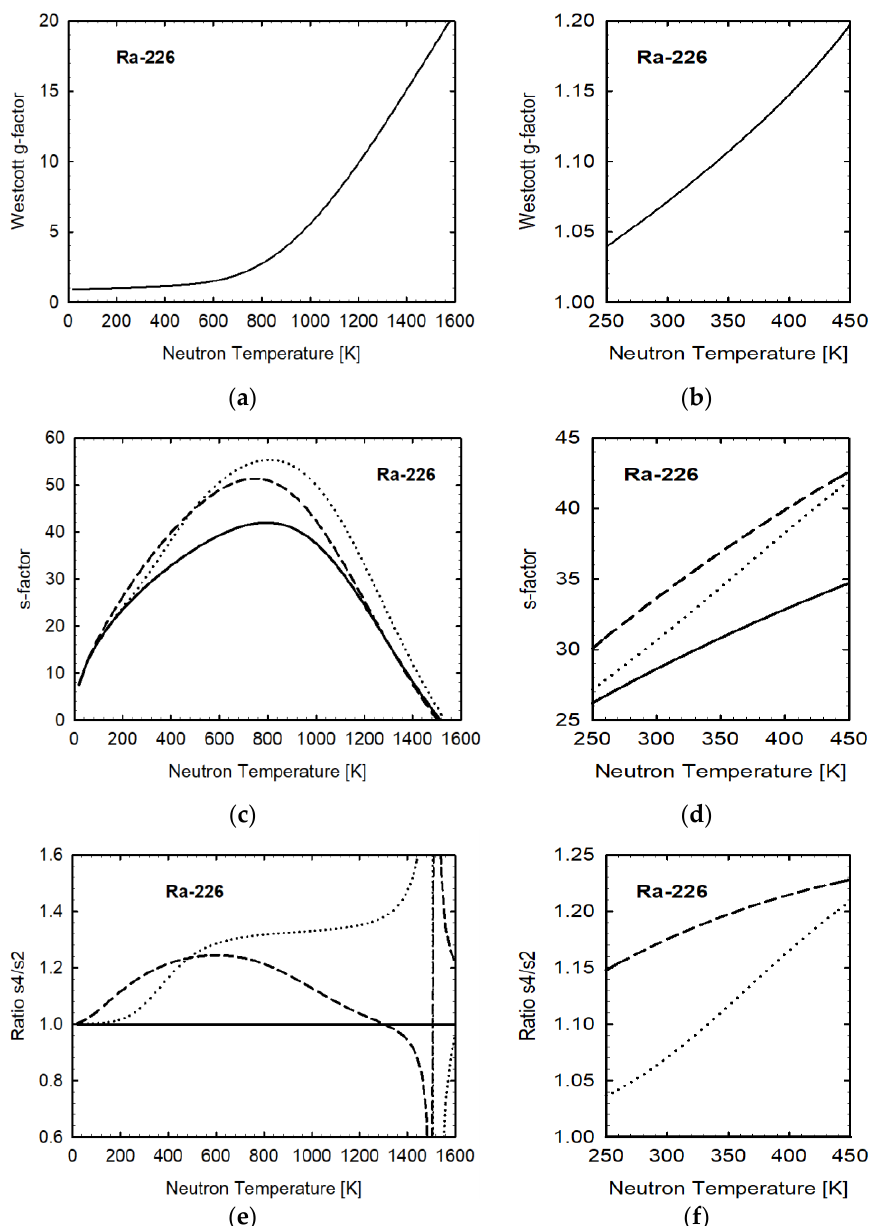
Figure 13. ( a ) Westcott g-factor for 226 Ra as a function of neutron temperature 𝑇 𝑛 ; ( b ) Expanded figure of ( a ); ( c ) s-factors, s 2𝑊 (solid line), s 4𝑊 (dotted line), s 4𝐻 (dashed line) for 226 Ra as a function of neutron temperature 𝑇 𝑛 ; ( d ) Expanded figure of ( c ); ( e ) Ratios of s-factors, s 4𝑊 /s 2𝑊 (dotted line) and s 4𝐻 /s 2𝑊 (dashed line) for 226 Ra; ( f ) Expanded figure of ( e ).